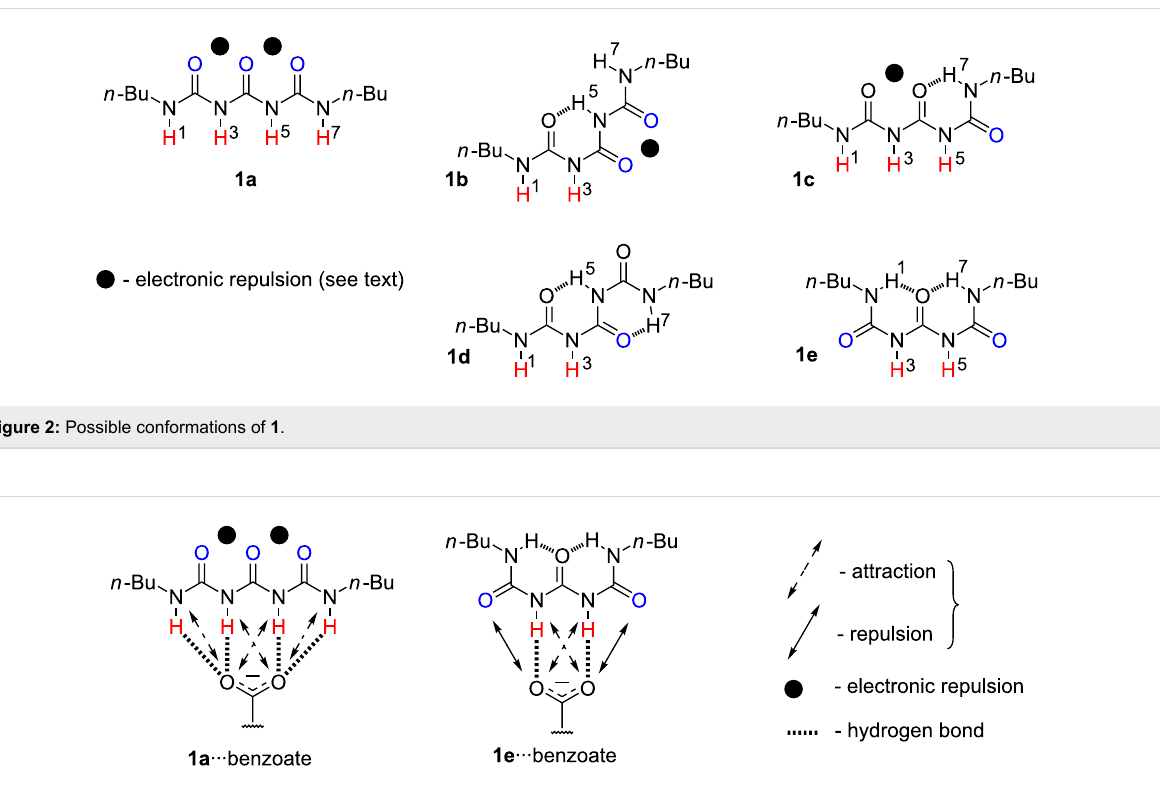
Figure 3: Driving forces influencing association exemplified on two "extreme" conformations of 1 ∙∙∙ benzoate.